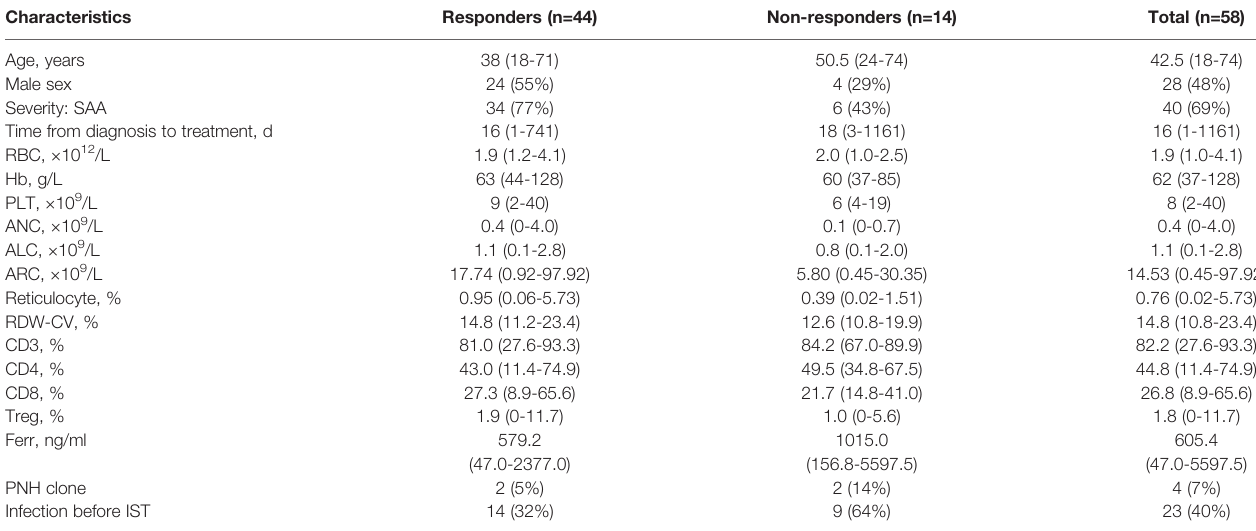
TABLE 1 | Baseline clinical and laboratory characteristics *